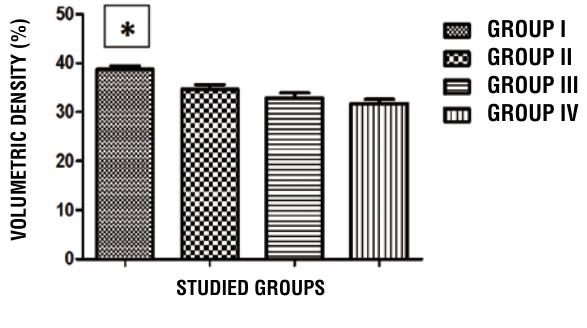
Figure 1 - volumetric density (%) of collagen fibers in the rat bladders according to the studied